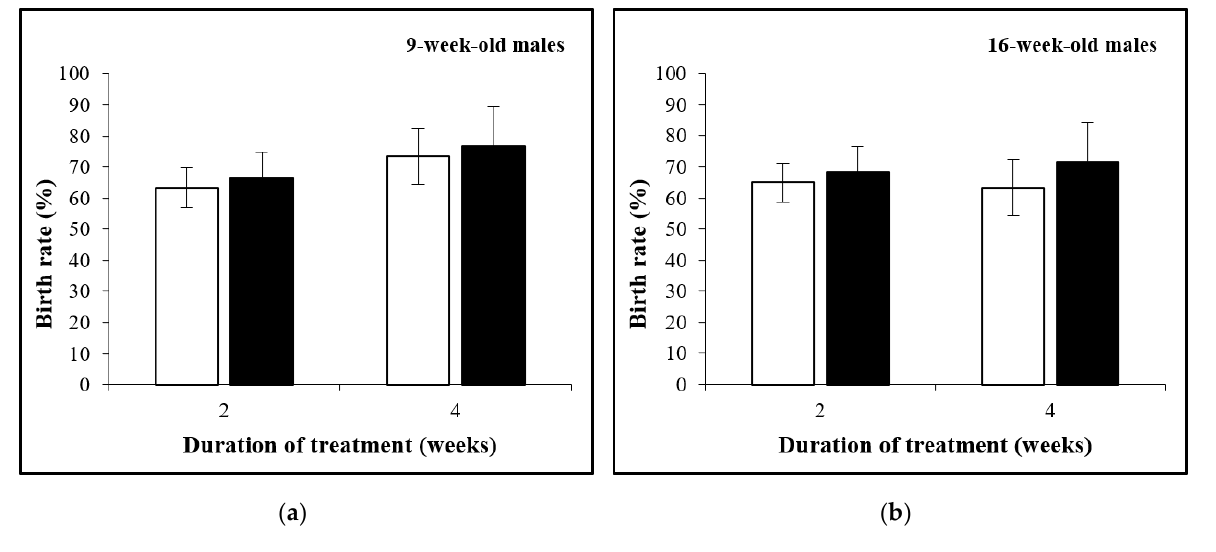
Figure 3. The birth rate with spermatozoa obtained from 9-week-old ( a ) and 16-week-old males ( b ) treated (black) or not treated (white) with D-Asp.